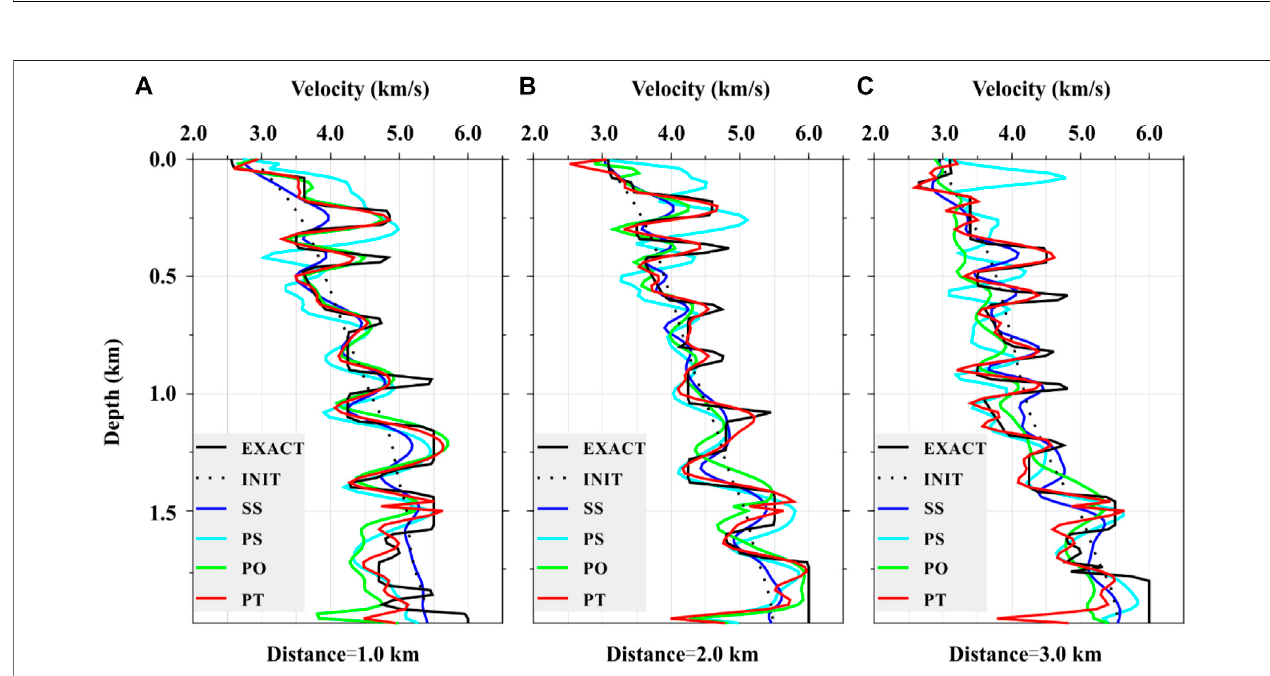
FIGURE 9 | Velocity pro fi les versus depth from the inversion results at distances of1.0 km (A) , 2.0 km (B) , and 3.0 km (C) . Velocity pro fi les of the initial model and the actual model are also plotted as references.